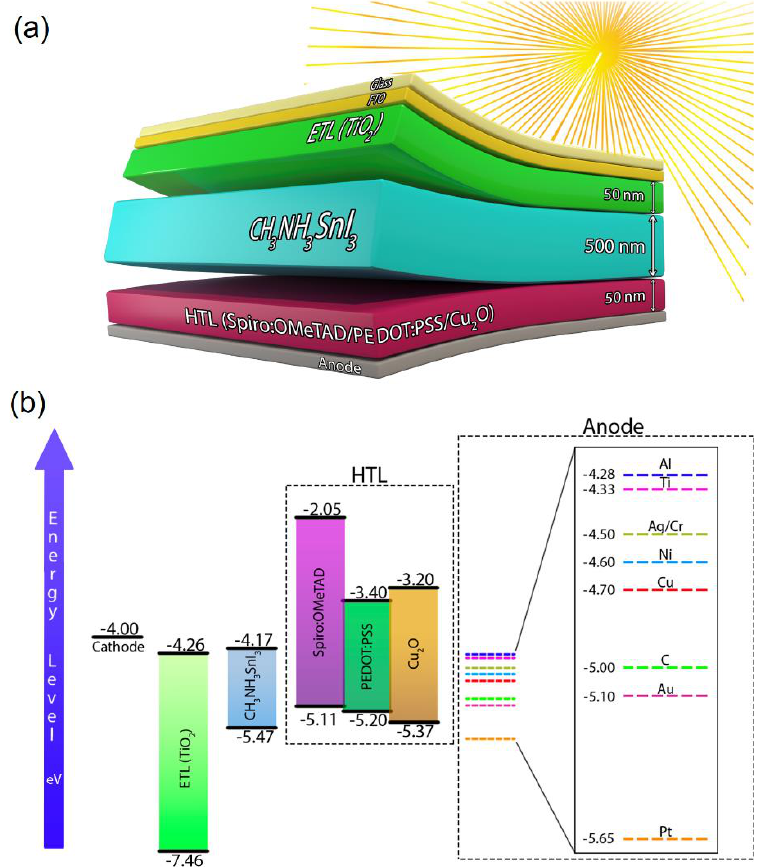
Figure 2. Schematic diagram of the studied perovskite solar cell ( a ) and energy band alignment ( b ). For all simulations of the photovoltaic cell under illumination the standard photo- voltaic radiation spectrum AM 1.5G was used (1000 W/m 2 , T = 300 K). The CH 3 NH 3 SnI 3 layer thickness remained fixed and equal to 500